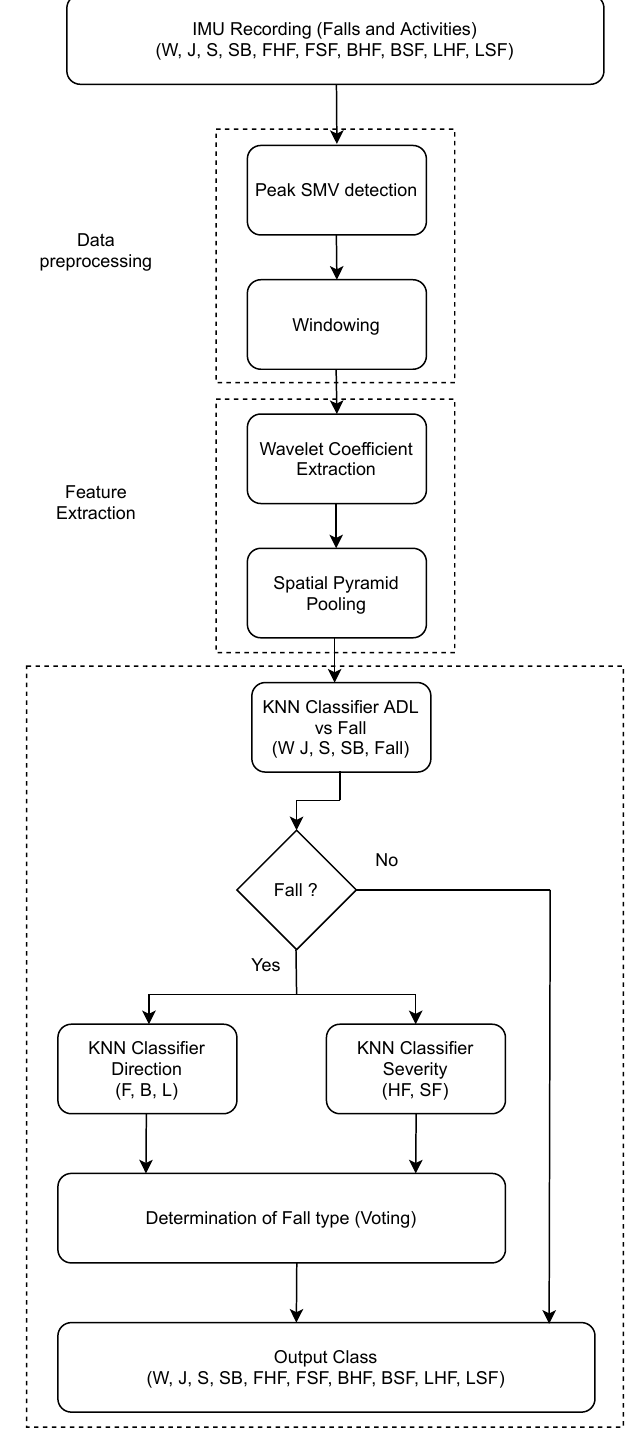
Figure 1. Hierarchical classification scheme for ADL and Fall